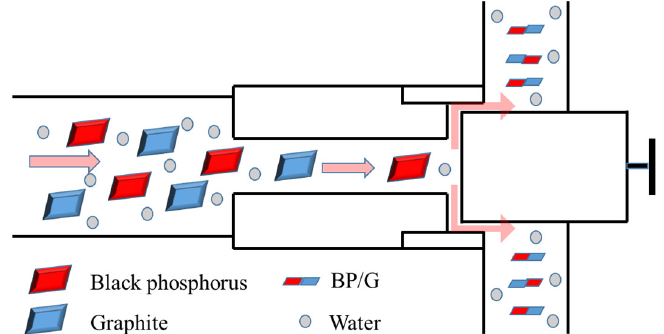
Figure 1. Schematic diagram to synthesize BP/G composite material by a high-pressure nano homogenizer machine.